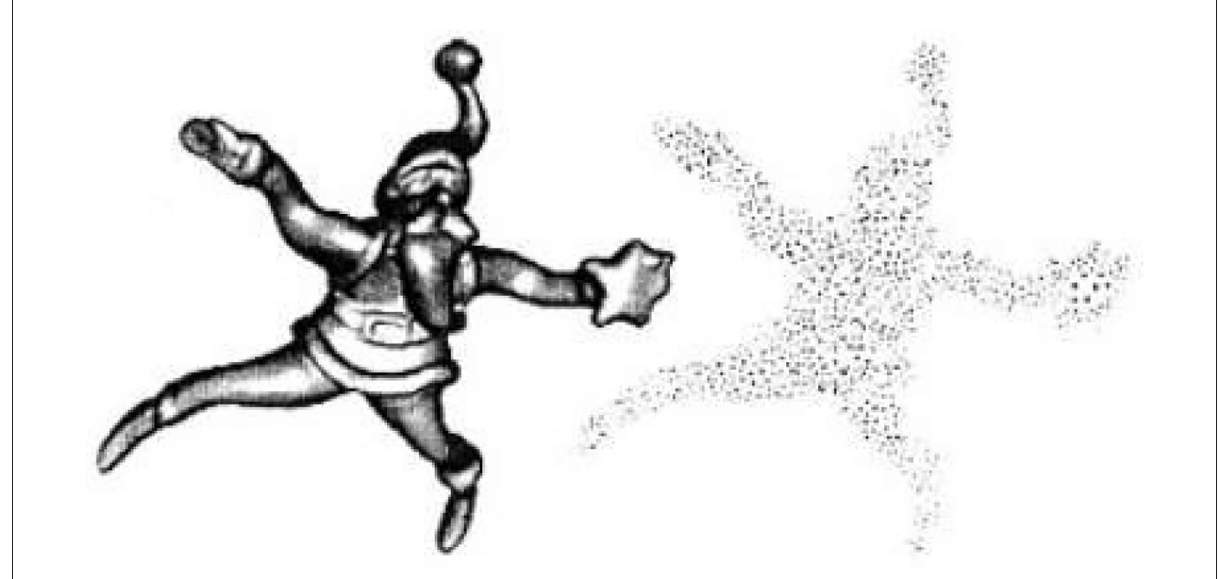
FIGURE3 An example of simulation of particle.